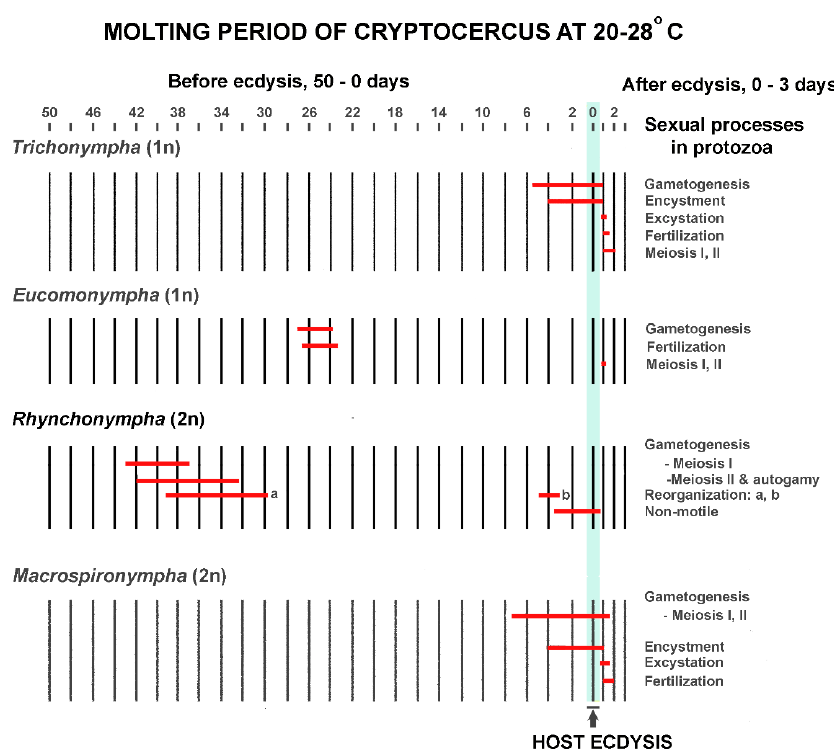
Figure 3. Examples of timing of different phases of the sexual/encystment (SE) cycle in relation to the molting period of the host in four genera of flagellates in the gut of Cryptocercus punctulatus . For each genus, the data are summed from several hosts, thus giving the time span during which the processes may occur. In Rhynchonympha , ‘reorganization a’ refers to unsynchronized partial re-organization of the centrioles; ‘reorganization b’ refers to synchronized loss and renewal of all the other extranuclear organelles. After Cleveland ([83] Table 2, with permission from John Wiley and Sons).